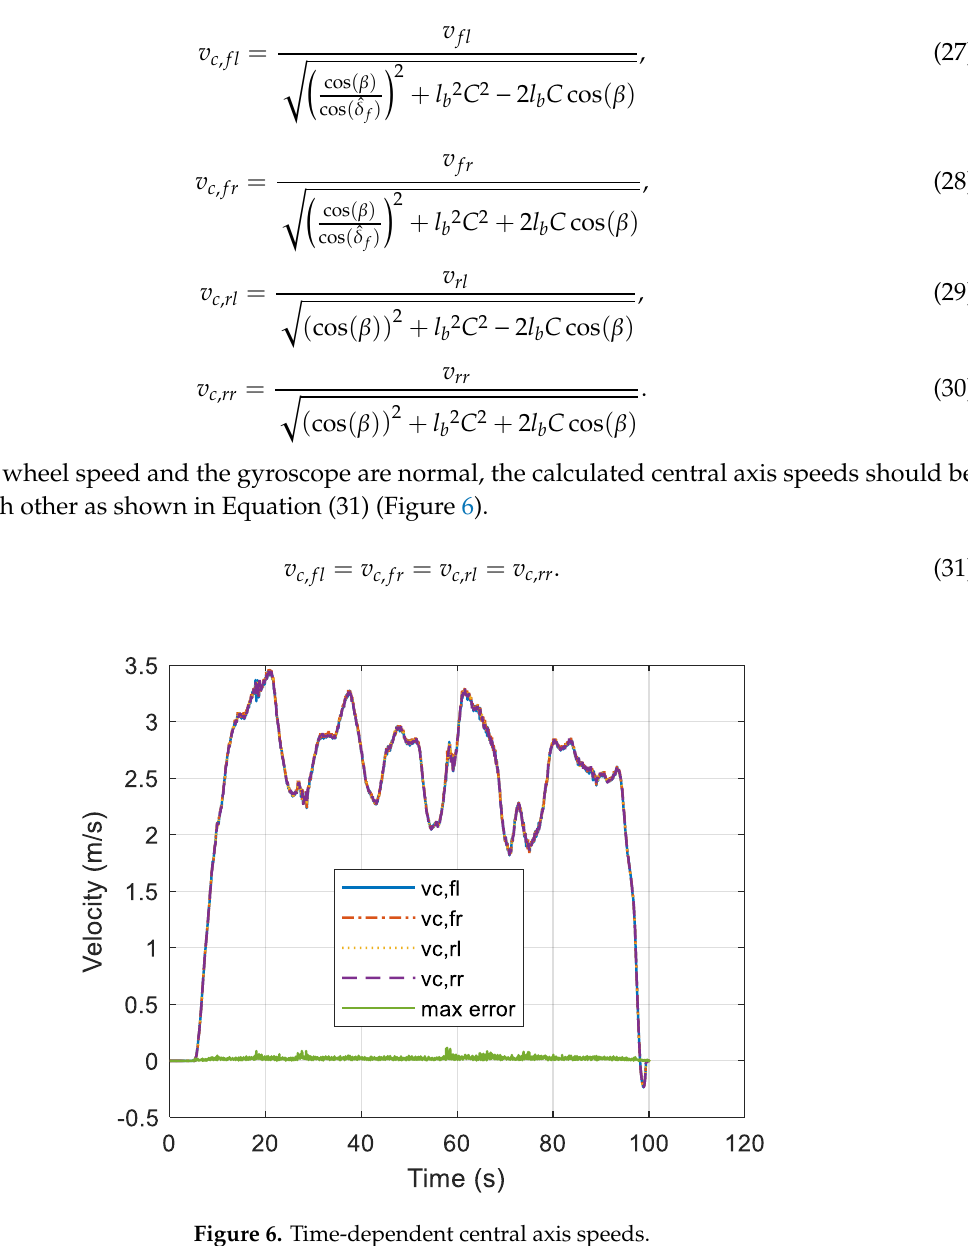
Figure 6. Time-dependent central axis speeds.